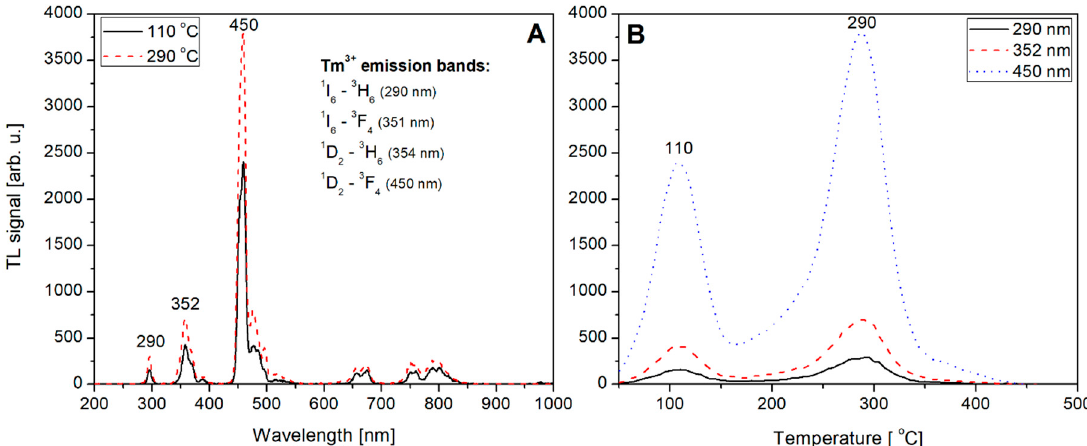
Figure 11. TL emission spectra (panel A ) measured for Tm-doped (0.8) LiMgPO 4 crystal at different temperatures corresponding to the glow-peaks maxima. TL glow-curves (panel B ) measured for the same Tm-doped LiMgPO 4 crystal (irradiated with beta radiation) at different wavelengths corresponding to emission maxima.